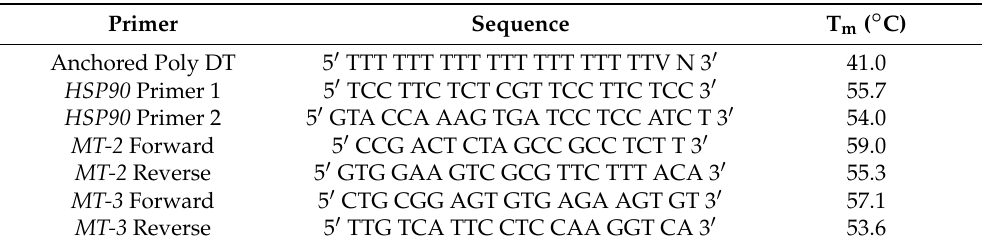
Table 5. A LightCycler 480 instrument (Roche Molecular Diagnostics, Pleasanton, CA, USA) was used for qPCR amplification and monitoring, according to the PowerUp SYBR Green Master Mix thermal cycling protocol guidelines. Based on the primers used, the annealing temperature for the qPCR was set at 58 ◦ C. qPCR data was analyzed using the ∆∆ C P method [69]. The presence of MT3 in the cell lines was confirmed by western blot analysis and by SDS-PAGE gels with purified Mt3 as a control. Table 5. Reverse transcription and PCR primers used in this